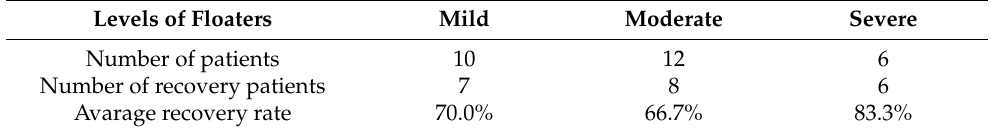
Avarage recovery